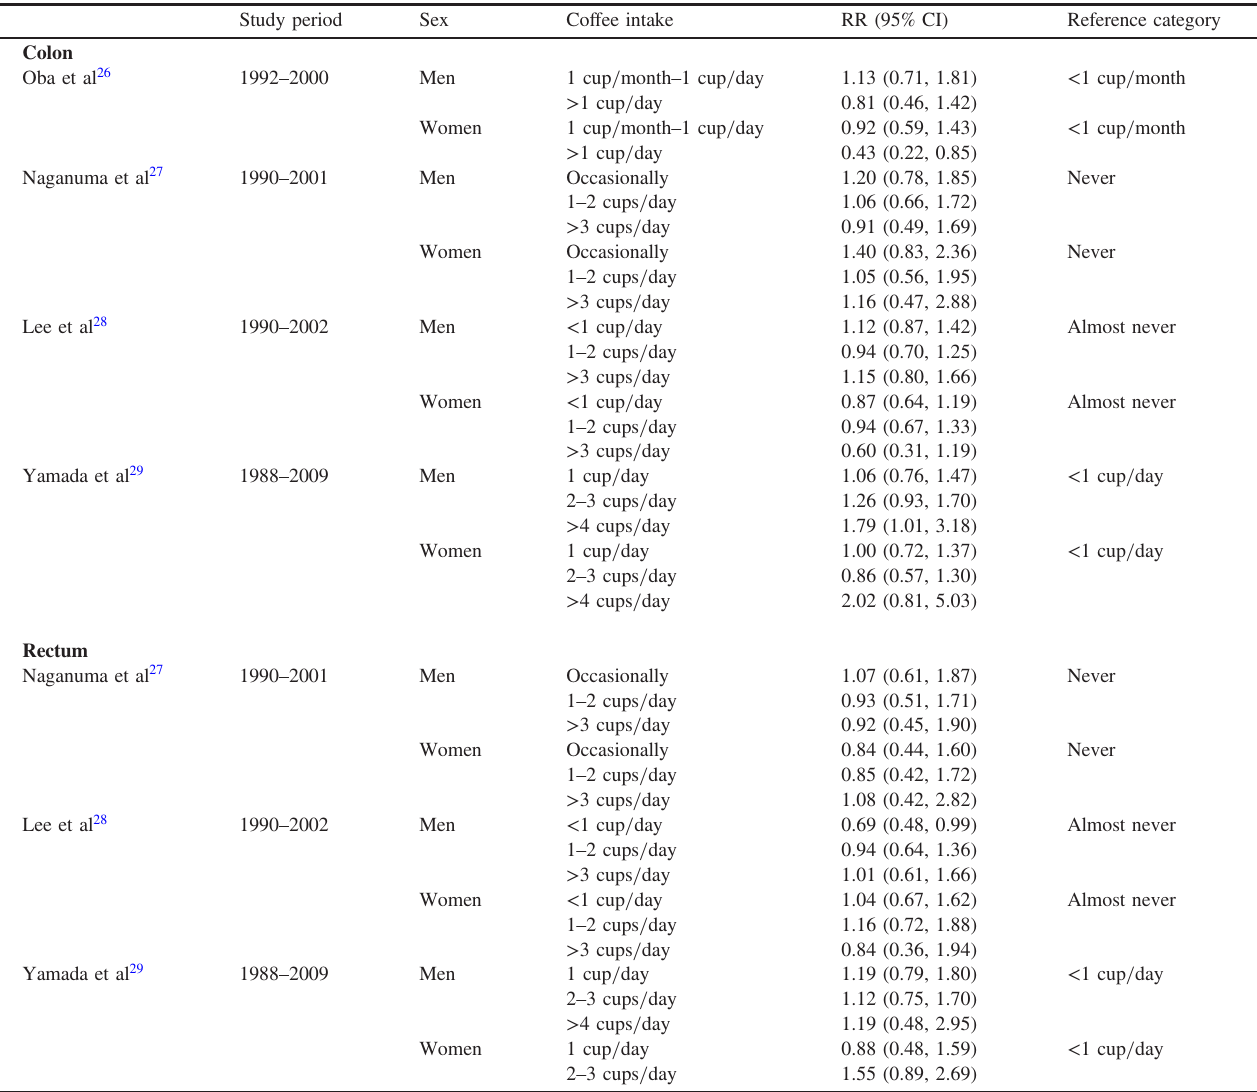
Table 1. Characteristics of cohort studies evaluating co ff ee consumption and colorectal cancer risk included in a